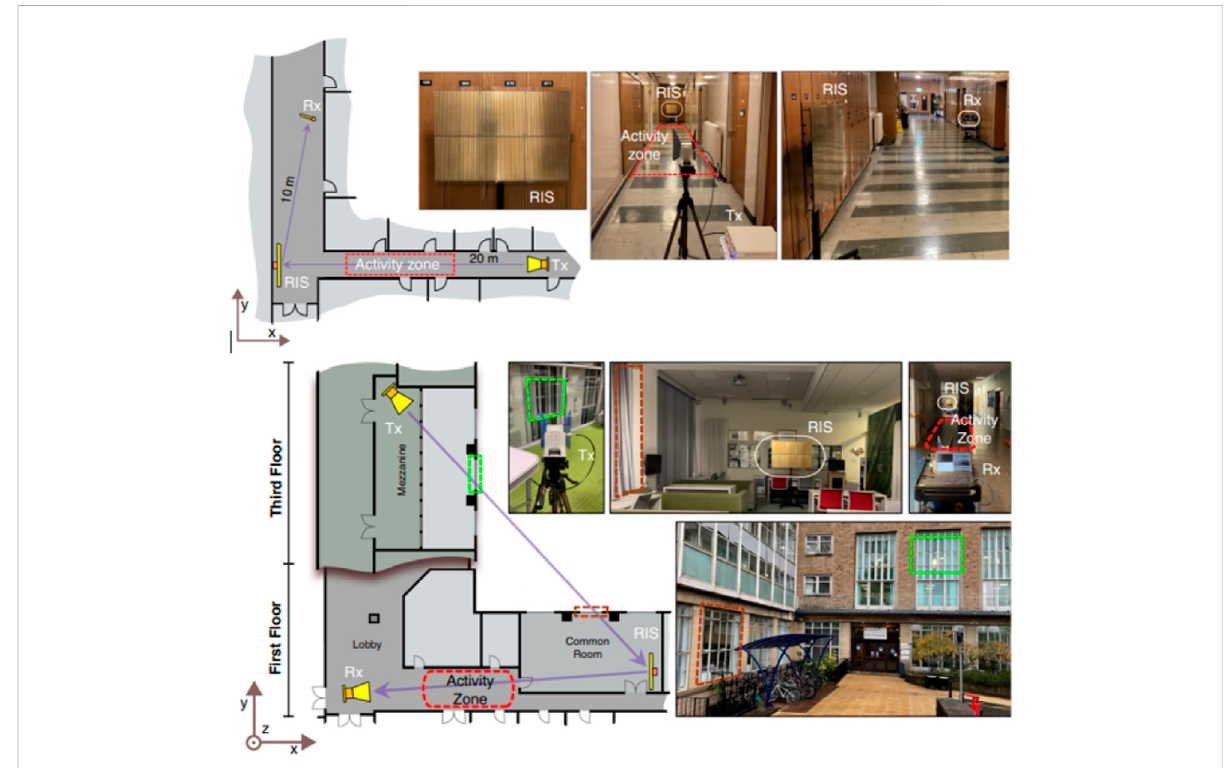
FIGURE 17 Two complex environments using intelligent wireless walls (IWW) (Usman et al.,